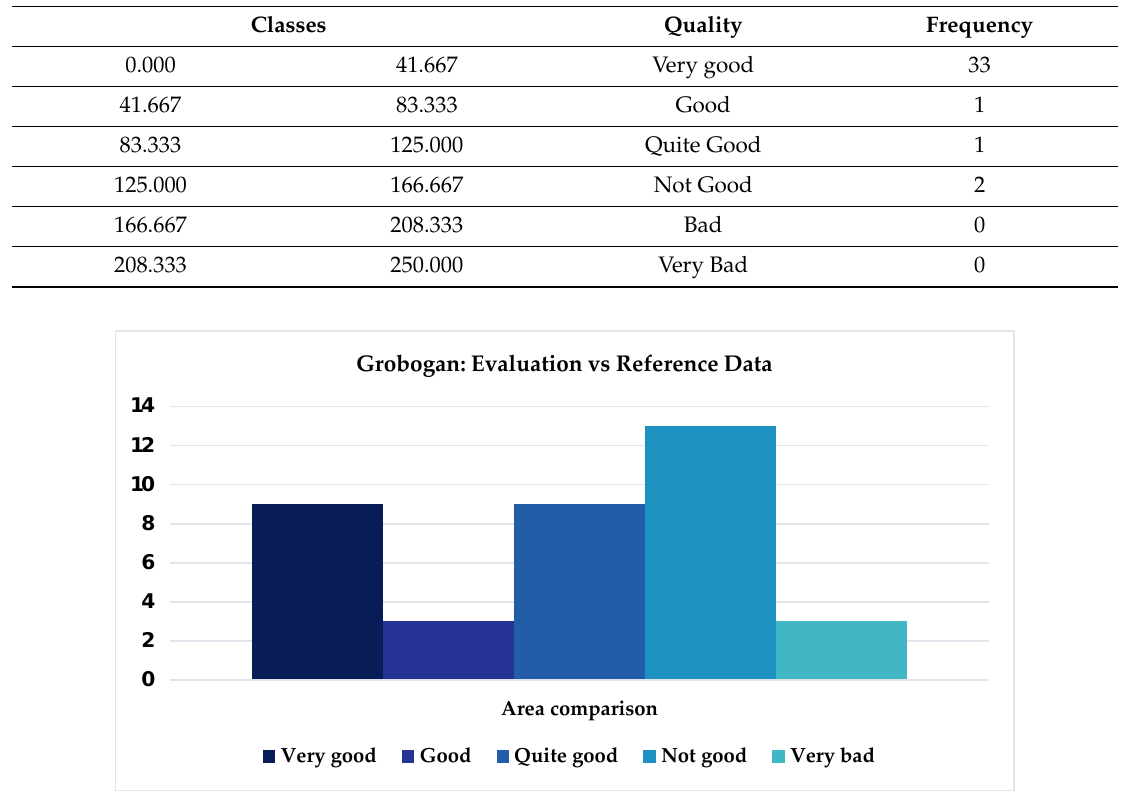
Figure A3. Evaluation and reference dataset analysis in Grobogan.